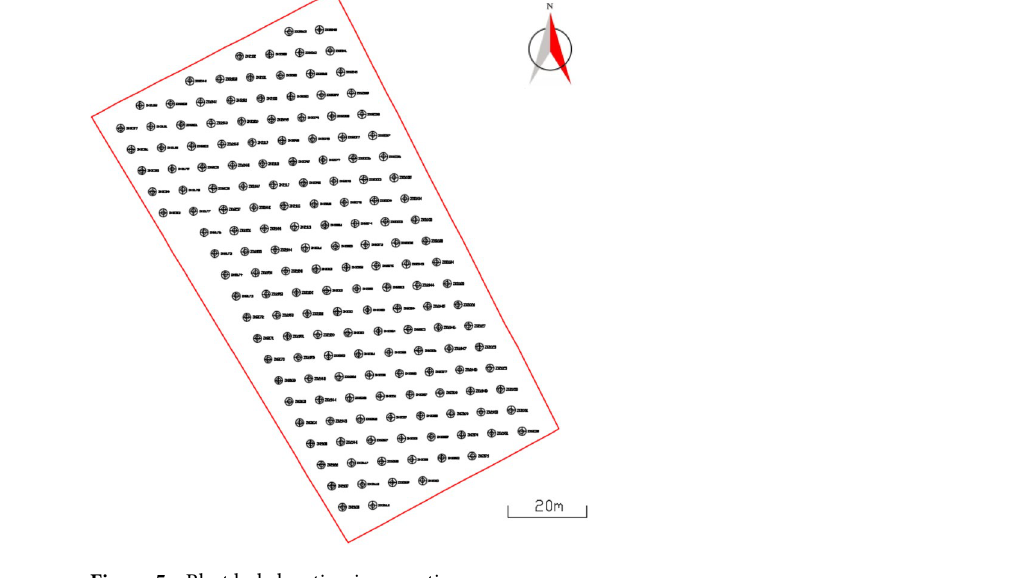
Figure 5. Blast hole location in operation range.